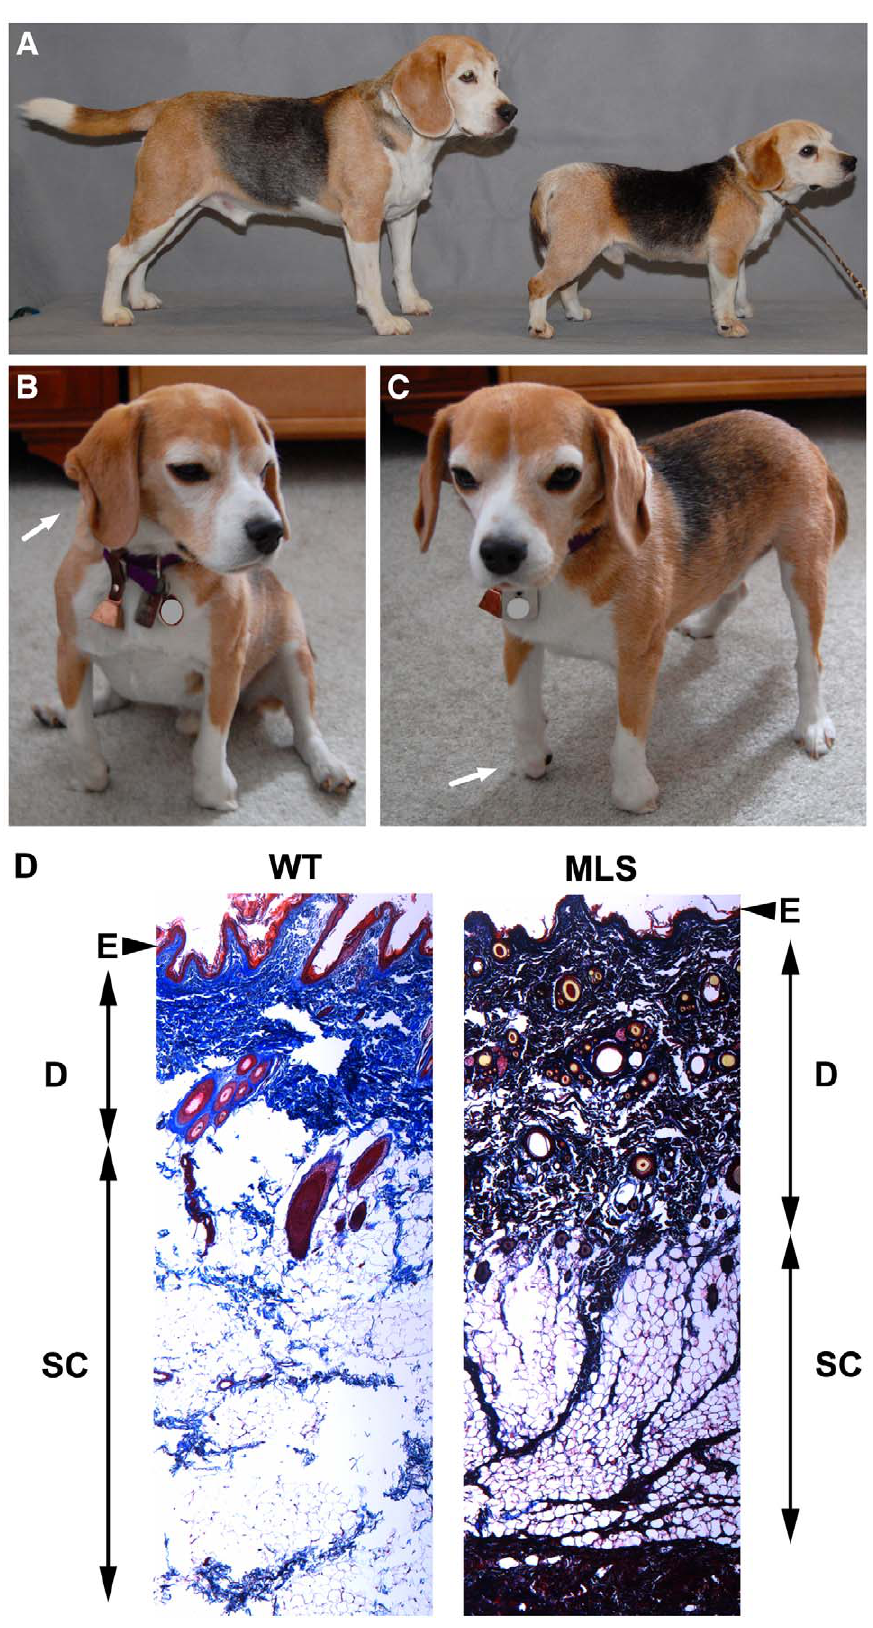
Figure 1. Phenotypic presentation of MLS in Beagle dogs. ( A ) Non-affected (left) and affected (right) Beagles matched by age, sex, and variety. Note short stature of affected dog. ( B ) Affected dog showing ear crease (arrow) and unusual stiff sitting posture. ( C ) Same dog as in B showing hyper-